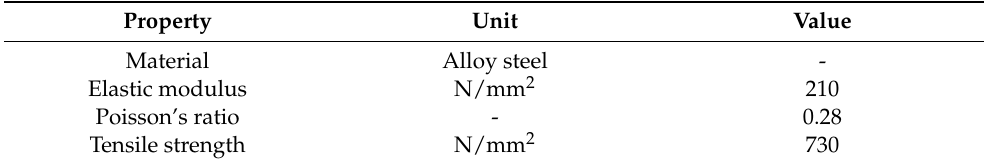
Figure 1. CFD analysis model of perforated road sign. Table 1. Material of perforated road sign.